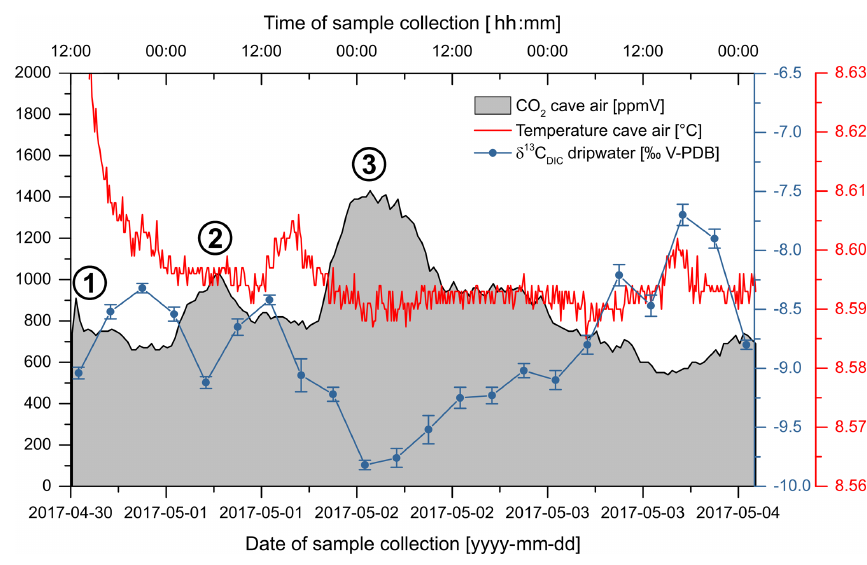
Figure 7. Time series of T , CO 2 and δ 13 C DIC generated during a first case study applying the GUARD autosampler (units are given in the legend). Cave air CO 2 concentrations and dripwater δ 13 C DIC values correlate negatively. Main CO 2 peaks are highlighted with circled